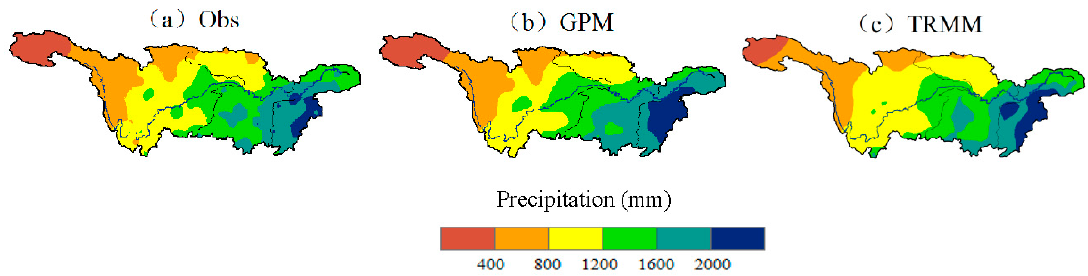
Figure 4. Spatial distribution of the mean annual precipitation for GPM IMERG v5 and TRMM 3B42 v7 from April 2014 to December 2017 over the Yangtze River basin. ( a ): Obs; ( b ): GPM; ( c ): TRMM)